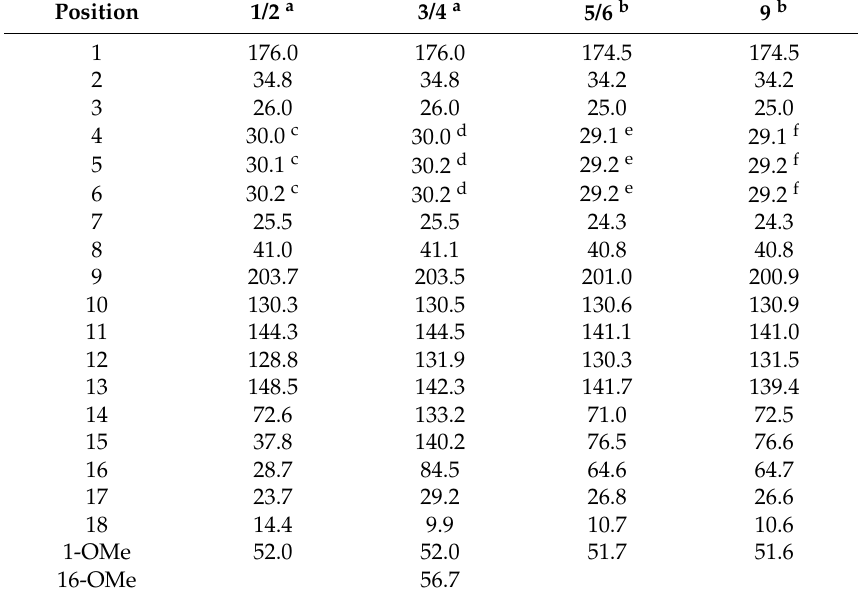
Table 2. 13 C NMR data for 1 – 6 and 9 (150